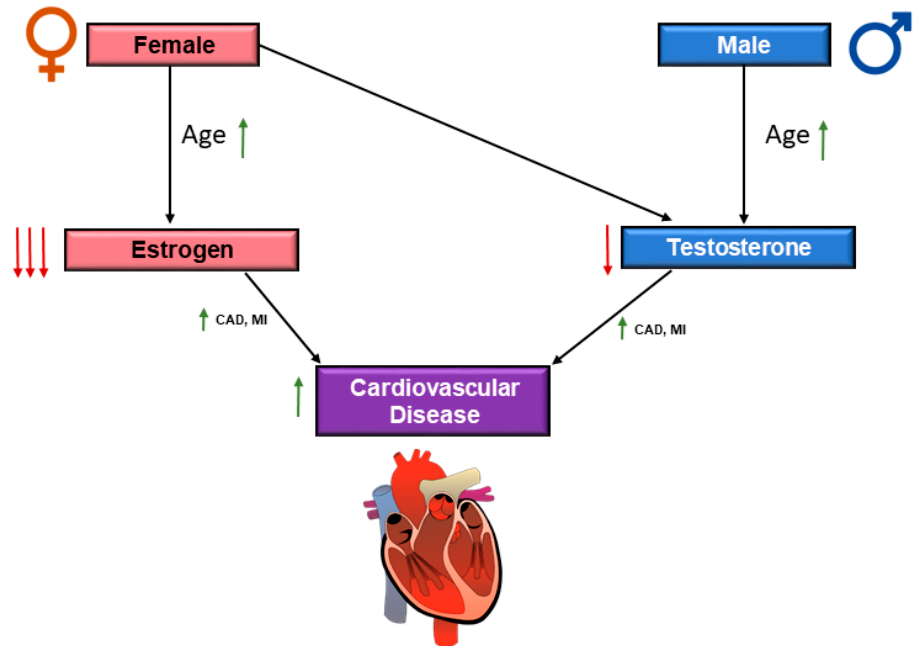
Figure 2. Schematic diagram of the influence of sex hormones on cardiovascular disease (CVD). Male and females both demonstrate a decline in sex hormones, while hormonal decline is more drastic in females with the onset of menopause. The decline of sex hormones is associated with increased cardiac risk in both males and females, with the decline of testosterone and estrogen, respectively. In this figure indicates upregulation and indicates downregulation. Coronary artery disease (CAD) and myocardial infarction (MI).